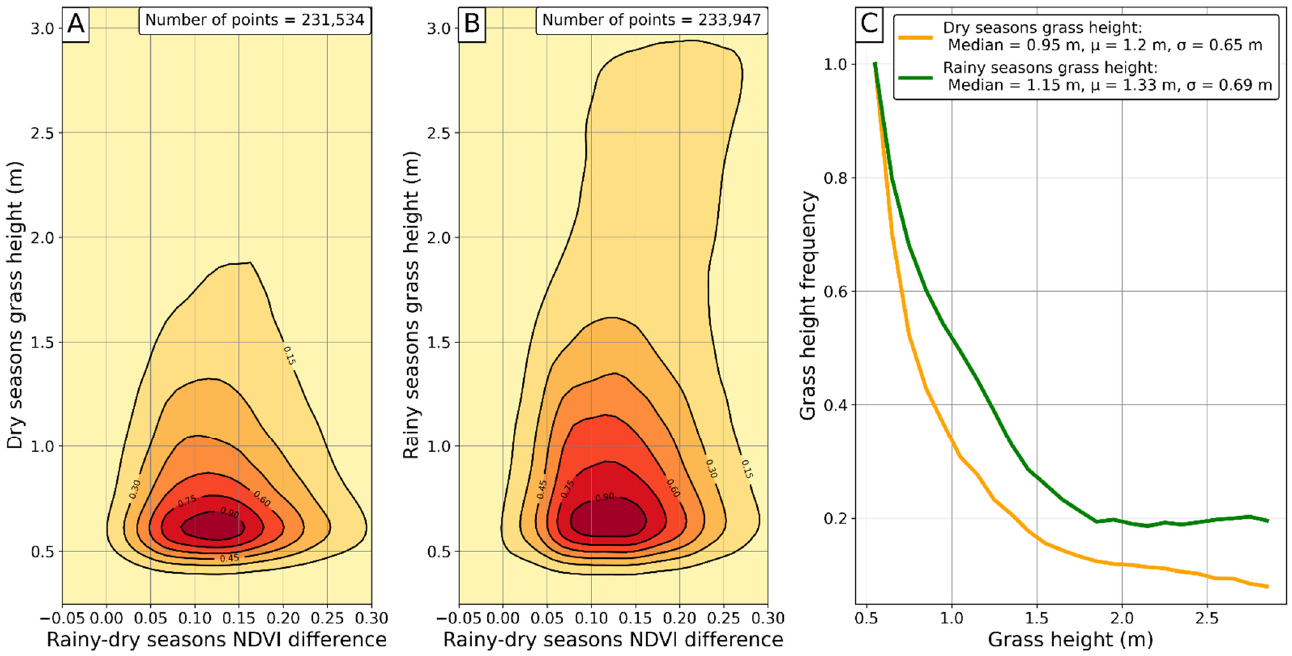
Figure 14. Seasonal vegetation height changes from ATL03 SVDA data between the dry and the rainy seasons of 2019 and 2020 for 231,534 (dry season) and 233,947 (wet season) points for the entire study area shown in the red polygon in Figures 1B,C and 2. ( A ) is the kernel density estimation of the joint distribution between NDVI difference and ATL03 SVDA dry season vegetation heights with a gaussian smoothing kernel and a step size of 100 in the x and y directions (with similar parameters in ( B )). Left column: dry seasons, center column: rainy seasons. The differences are visible at all percentiles, but most strongly for the 30% of the data at higher vegetation heights. The distribution of the dry and rainy season vegetation heights ( C ) show the largest differences for higher vegetation height, which is expected in the seasonal savanna ecosystem. A non-parametric KS tests indicate that the seasonal vegetation heights are drawn from different distributions ( p =